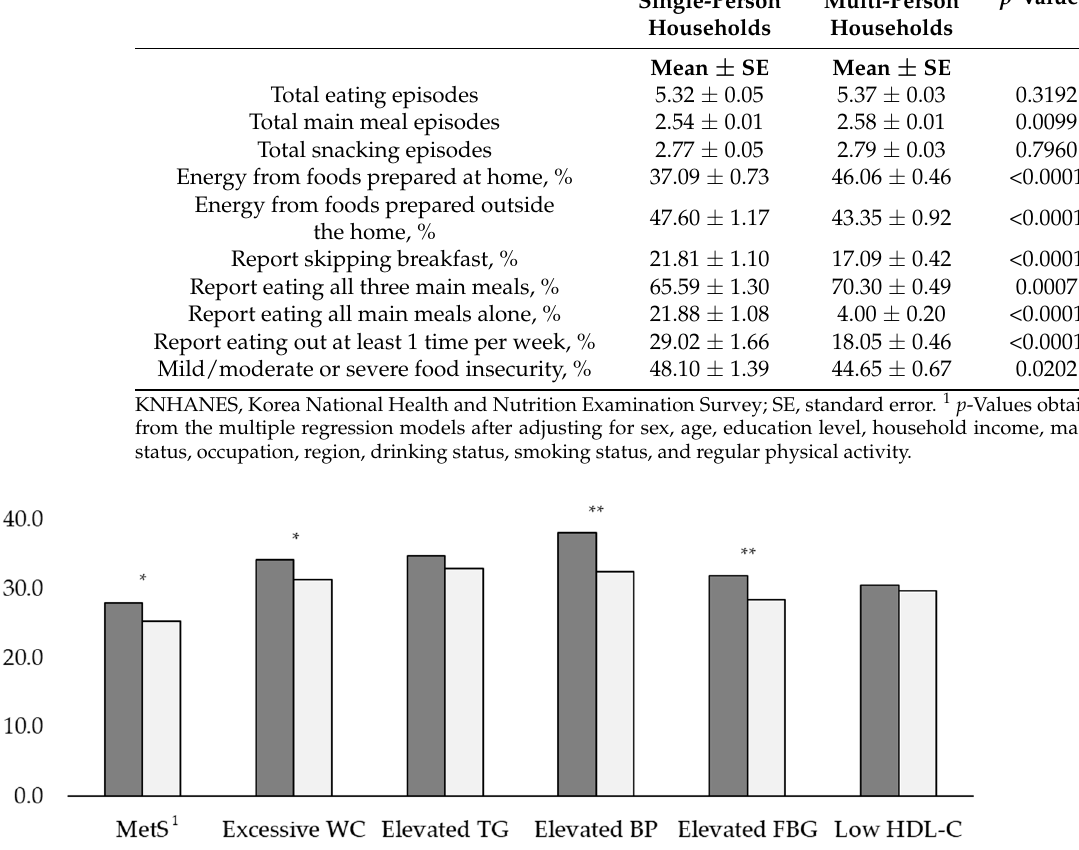
WC, waist circumference; TG, triglycerides; BP, blood pressure; FBG, fasting blood glucose; HDL-C, high-density lipoprotein